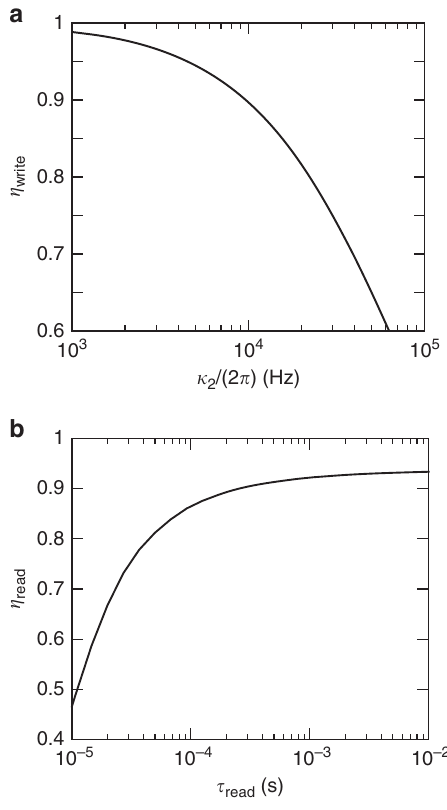
Figure 3 | Write and read efficiency. ( a ) Write efficiency as a function of the linewidth of the filter cavity k 2 . We have simulated a Cs-cell with wall length 2 L ¼ 300 m m and cavity beam waist w ¼ 55 m m corresponding to the cells being used in the proof-of-principle experiment. We have assumed a detuning of D B 2 p (cid:7) 900MHz, a pulse length of t int ¼ 10/ k 2 and a cell-cavity decay rate k 1 ¼ 2 p (cid:7) 46MHz. ( b ) Optimal readout efficiency as a function of the readout time t read without the filter cavity (corresponding to k 2 - N ). The efficiency was simulated for the same Cs-cells as the write efficiency and we have assumed that t read ¼ 3 = G read where G read is the readout rate, which is proportional to the classical drive intensity. The optical depth was assumed to be 168 as measured in the experiment. The finesse of the filter cavity was varied between 20 and 100 to get the optimal readout efficiency. We have included the full-level structure of 133 Cs in the simulations (see Supplementary Methods and Supplementary Fig.